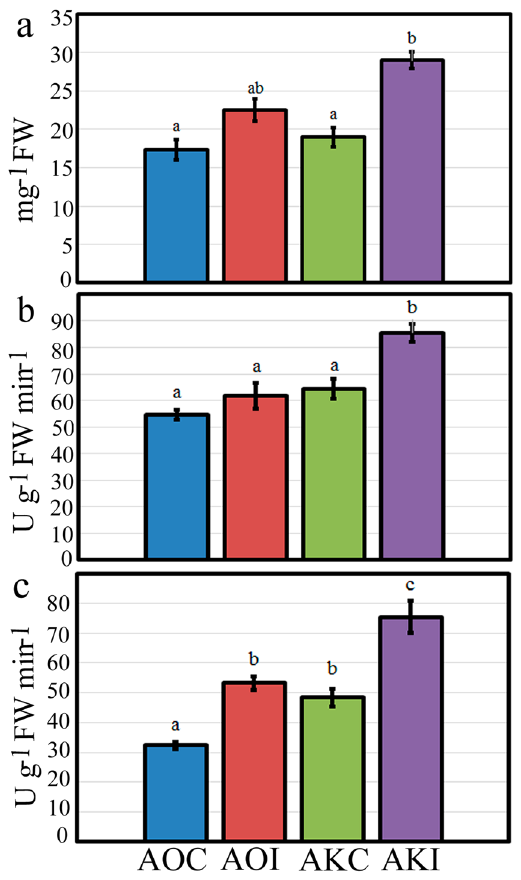
Figure 8. Accumulation of ( a ) total protein content, ( b ) peroxidase, and ( c ) catalase activities in Asparagus officinalis inoculated with Phomopsis asparagi (AOI) and A . kiusianus inoculated with P . asparagi (AKI). A . officinalis and A . kiusianus treated with sterile distilled water (AOC and AKC, respectively) served as controls. Values represent the mean ± standard error (SE) of three independent replicates ( n = 3). Different letters indicate statistically significant difference at P < 0.05 according to Tukey’s honest significant difference (HSD) post hoc